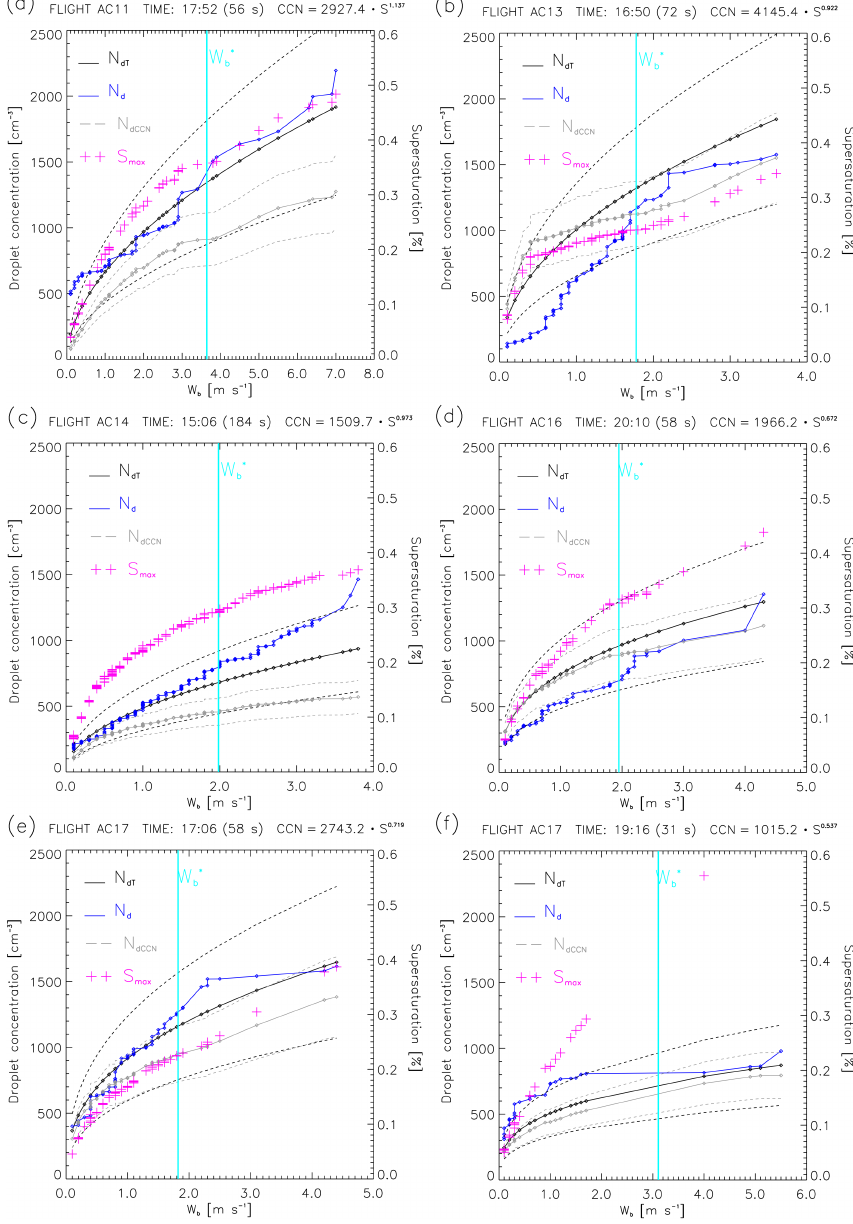
Figure 11. (a) – (f) N dCCN , S , N dT , and N d values are presented as a function of the cloud base updrafts ( W b ). This plot is based on the “probability matching method” (PMM) using the same percentiles for W b and N d ( N dCCN or N dT ). The values of N dCCN , N dT , and N d are shown on the left y axis and those of S are on the right y axis. The black dashed lines are the N dT uncertainties. The gray solid (dashed) lines are the N dCCN values (uncertainties). The effective updraft W ∗ for each flight segment is shown by the cyan line. The data are based on the b CAS-DPOL probe. The time period of measurements (sample size in seconds) and N CCN (S) equation are shown on the top of the figures.